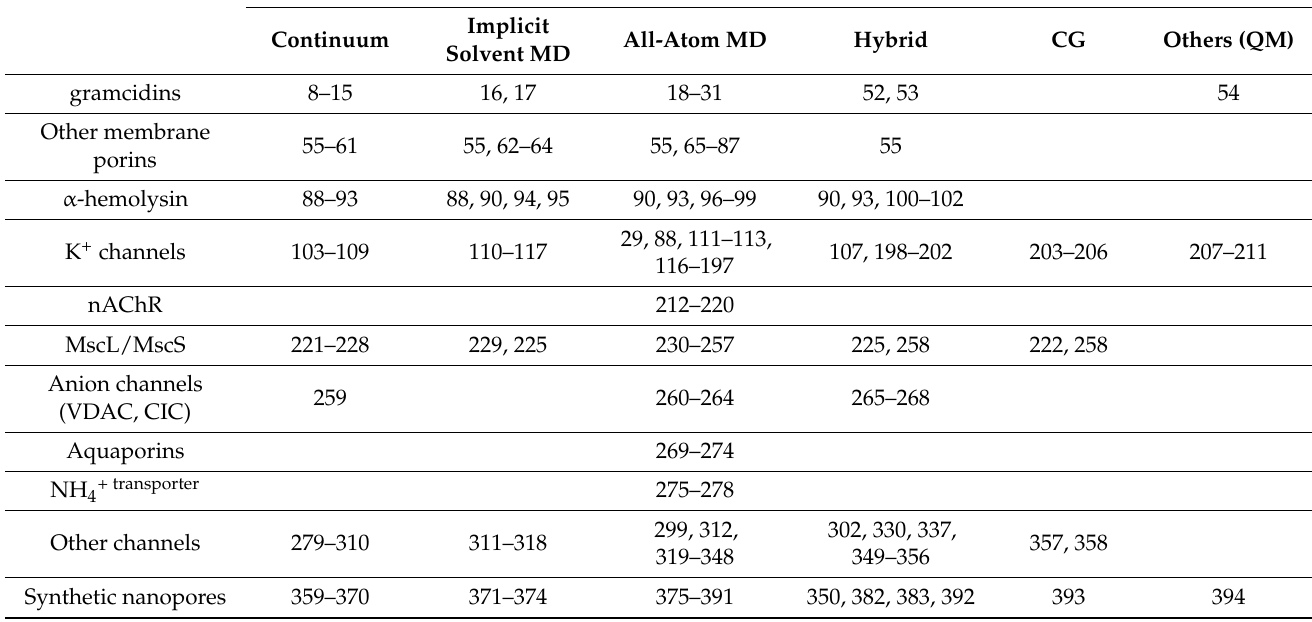
Table 1. Ion Channel modeling and simulation studies. The references quoted in the table are readily found as referenced in article [24]. Here the general area of ion channels are organized according to the system type and computational models employed. “Reprinted (adapted) with permission from